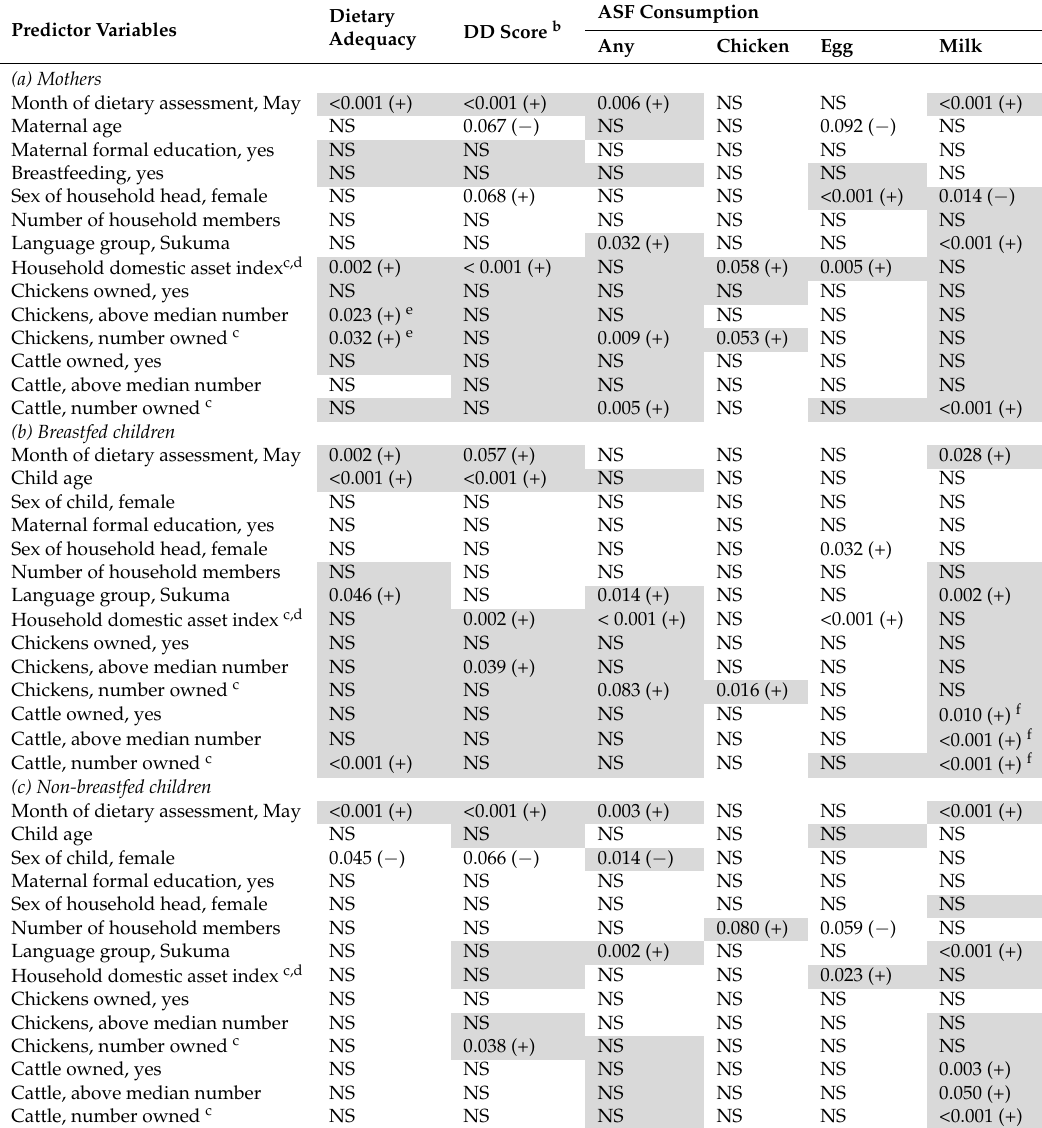
Table 3. Multivariable models a for maternal and child dietary adequacy, dietary diversity and ASF consumption, showing p -values and the direction of significant ( p < 0.05) and suggestive (0.05 ≤ p < 0.1) associations. Grey shading indicates significant and suggestive associations in univariable models (Table A2), and “NS” denotes non-significant associations in final multivariable